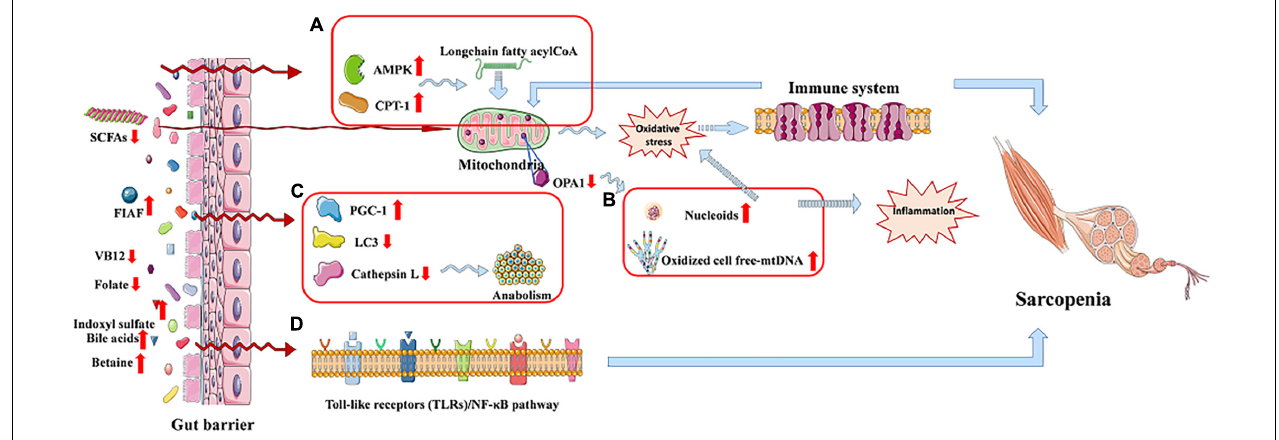
FIGURE 3 | The gut–muscle axis led to sarcopenia via regulating the processes of mitochondrial dysfunction and modulation of host gene expression. (A) AMP-activated protein kinase (AMPK) and carnitine palmitoyl transferase-1 (CPT-1) are increased. (B) Mitochondrial dysfunction. (C) Autophagy-lysosomal pathway related proteins reduced. (D) Cell signaling pathway regulation